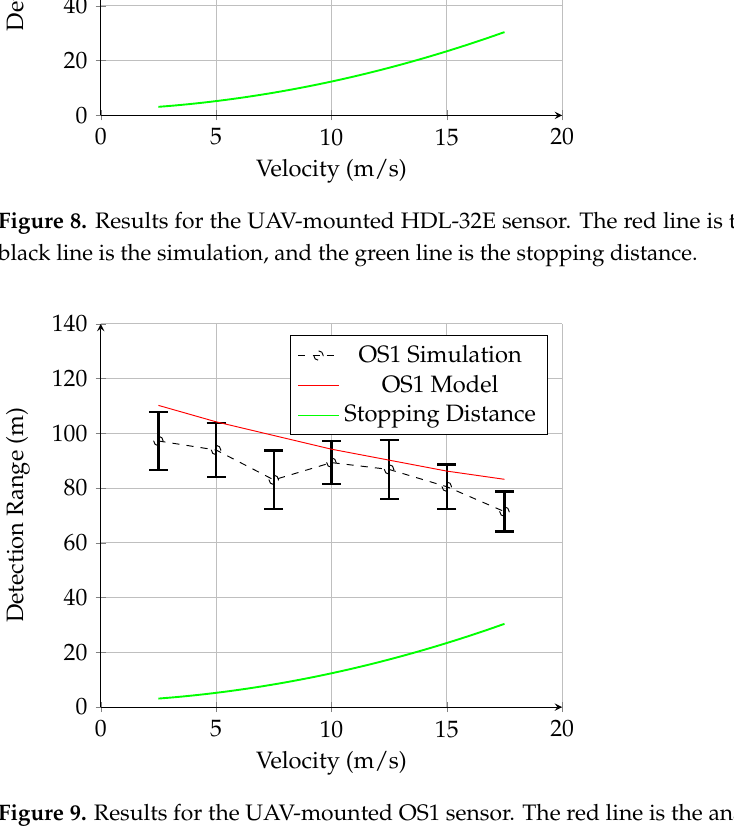
Figure 9. Results for the UAV-mounted OS1 sensor. The red line is the analytical model, the black line is the simulation, and the green line is the stopping distance.